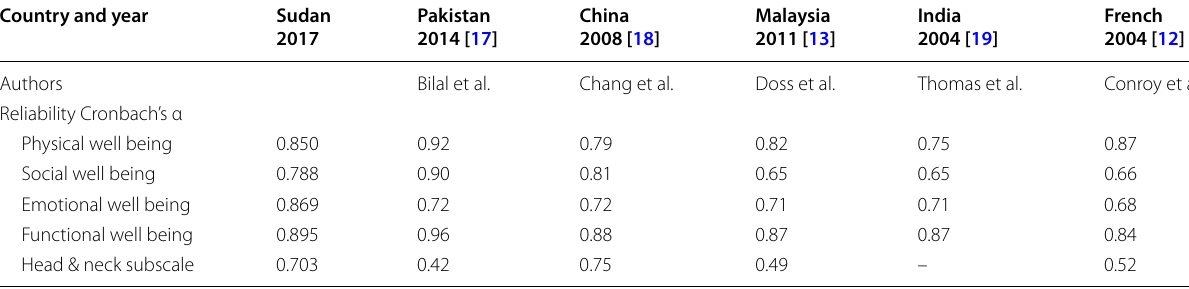
Table 6 Comparisons between Sudanese Arabic FACT-H&N and other translations Country and